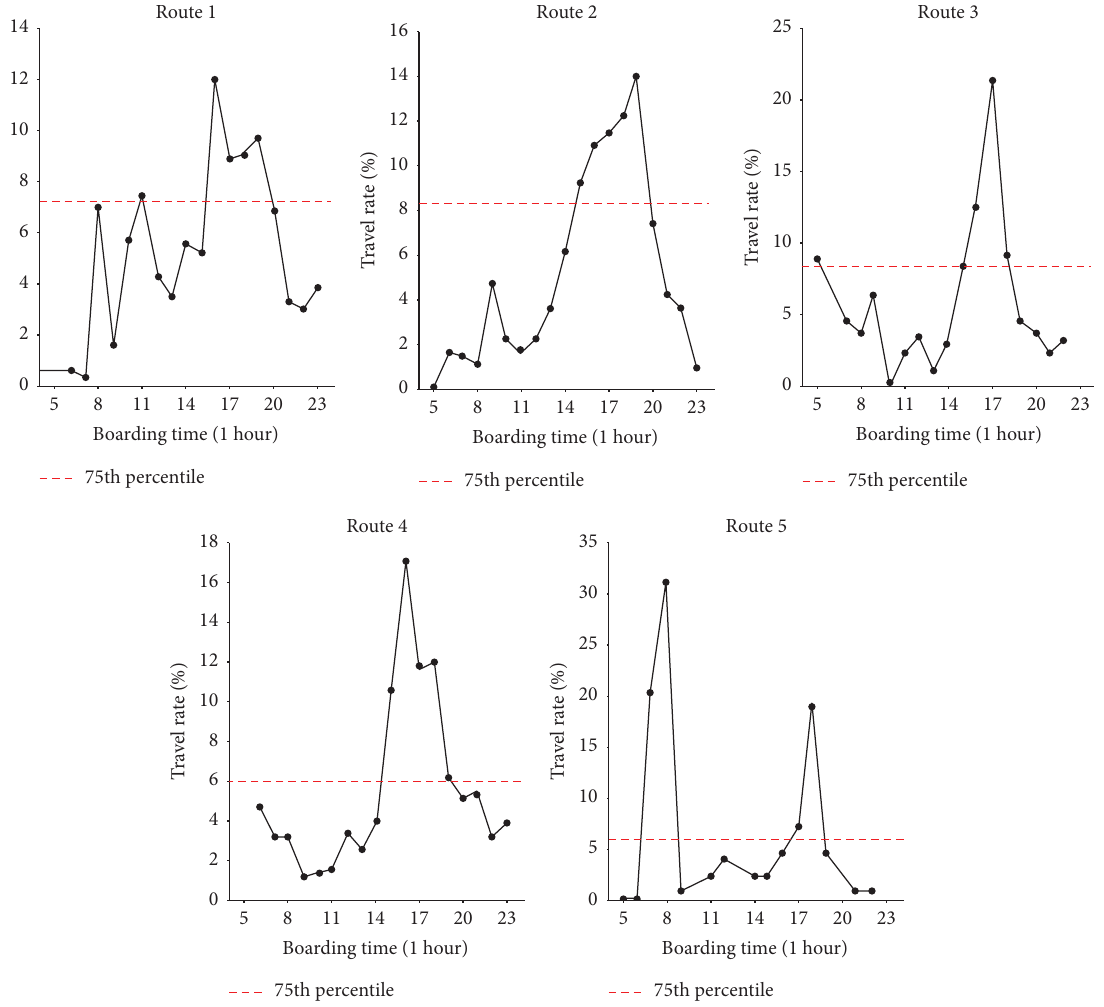
Figure 18: Travel rate by time for < traditional market >